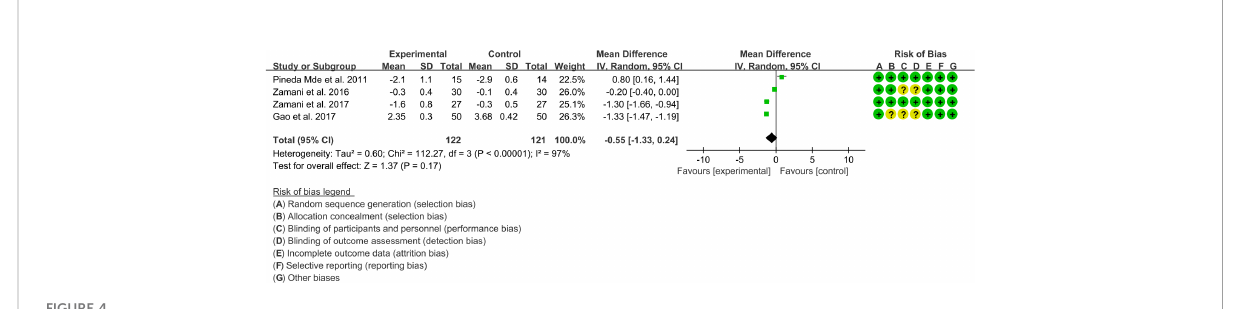
FIGURE 4 The results of DAS28 (CI, con fi dence interval; SD, standard deviation).